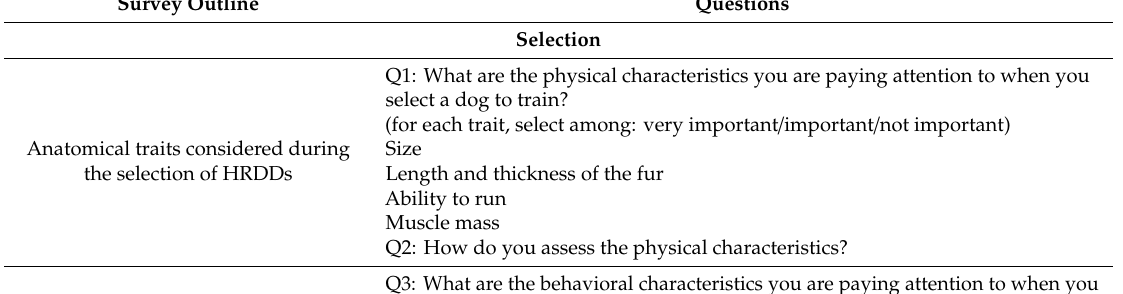
Table 2. Survey sent to handlers (N = 50) of human remains detection dog (HRDDs). Survey